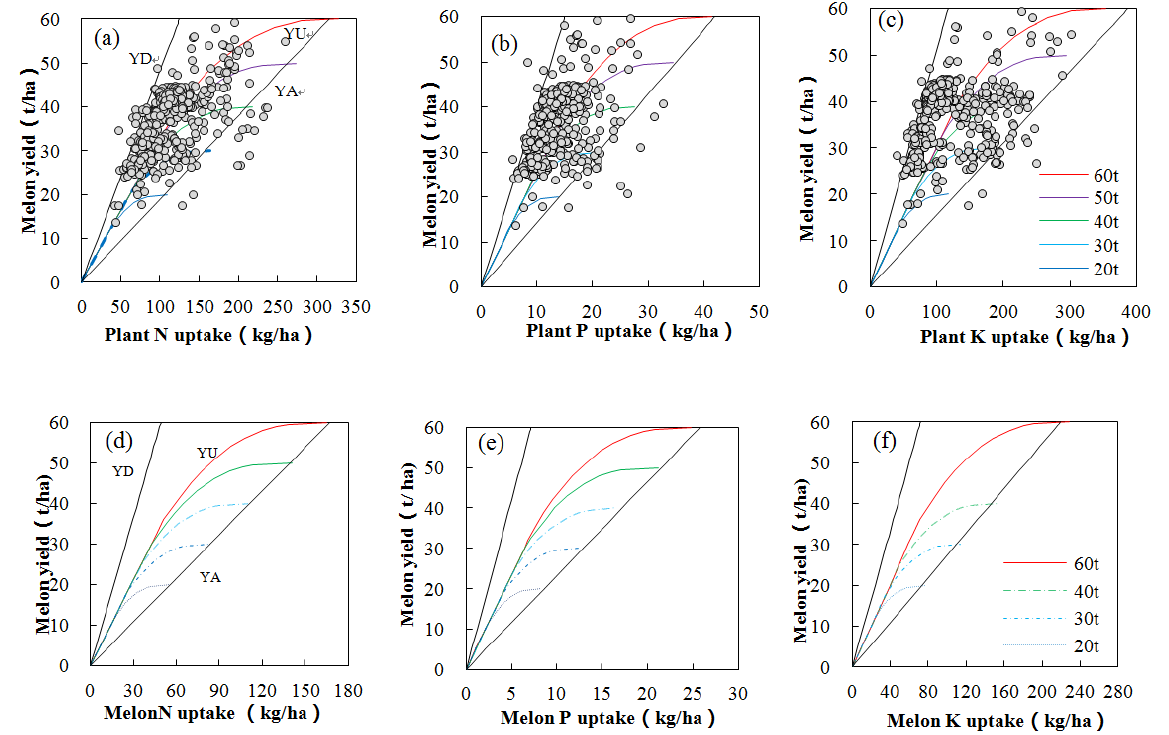
Figure 2. Relationship between melon fresh yield and N, P and K accumulation in the total plant above-ground parts at maturity ( a – c ) and fleshy melon N, P and K dry matter ( d – f ) under different target yields stimulated by the QUEFTS model. YD, YA and YU represented maximum dilution, maximum accumulation and balanced uptake of N, P and K in above-ground dry matter or in the fleshy fruit dry matter. Table 6. Balanced nutrient uptake requirements, internal efficiencies (IE, kg fleshy fruit per